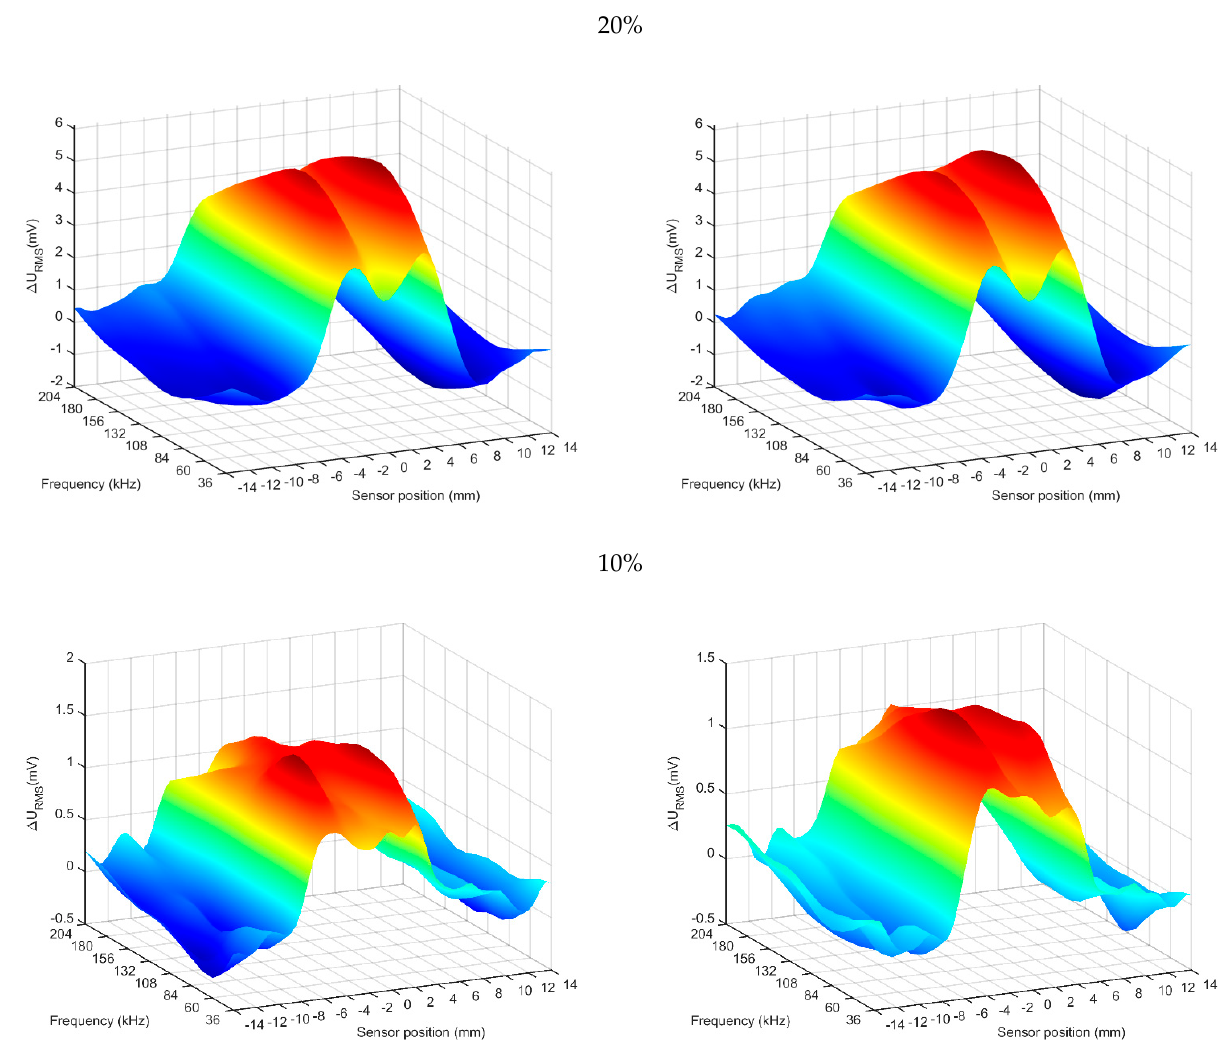
Figure 14. Comparison of the results obtained for the MFES-ECT and PMFES-ECT methods for various flaw depths in the range of 10–100%.